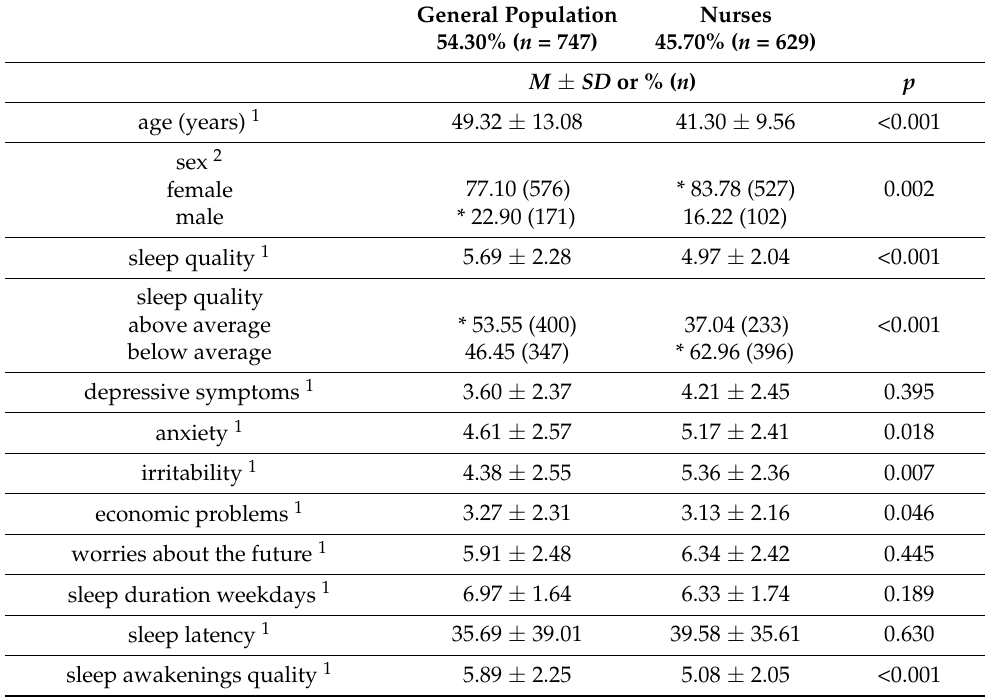
Table 3. Bivariate analysis of the variables in study ( n = 1376).